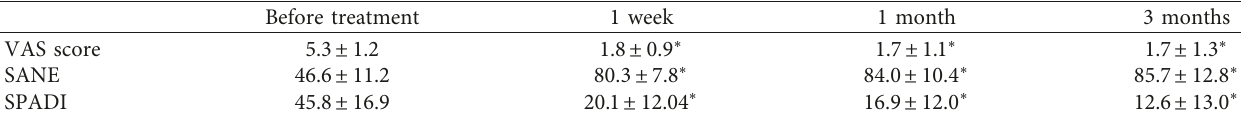
Table 2: Outcome measurements after